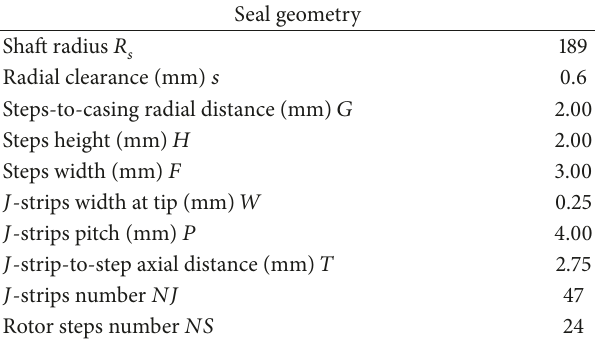
Figure 4: Parametric view of staggered labyrinth seal. Table 1: Seal geometry